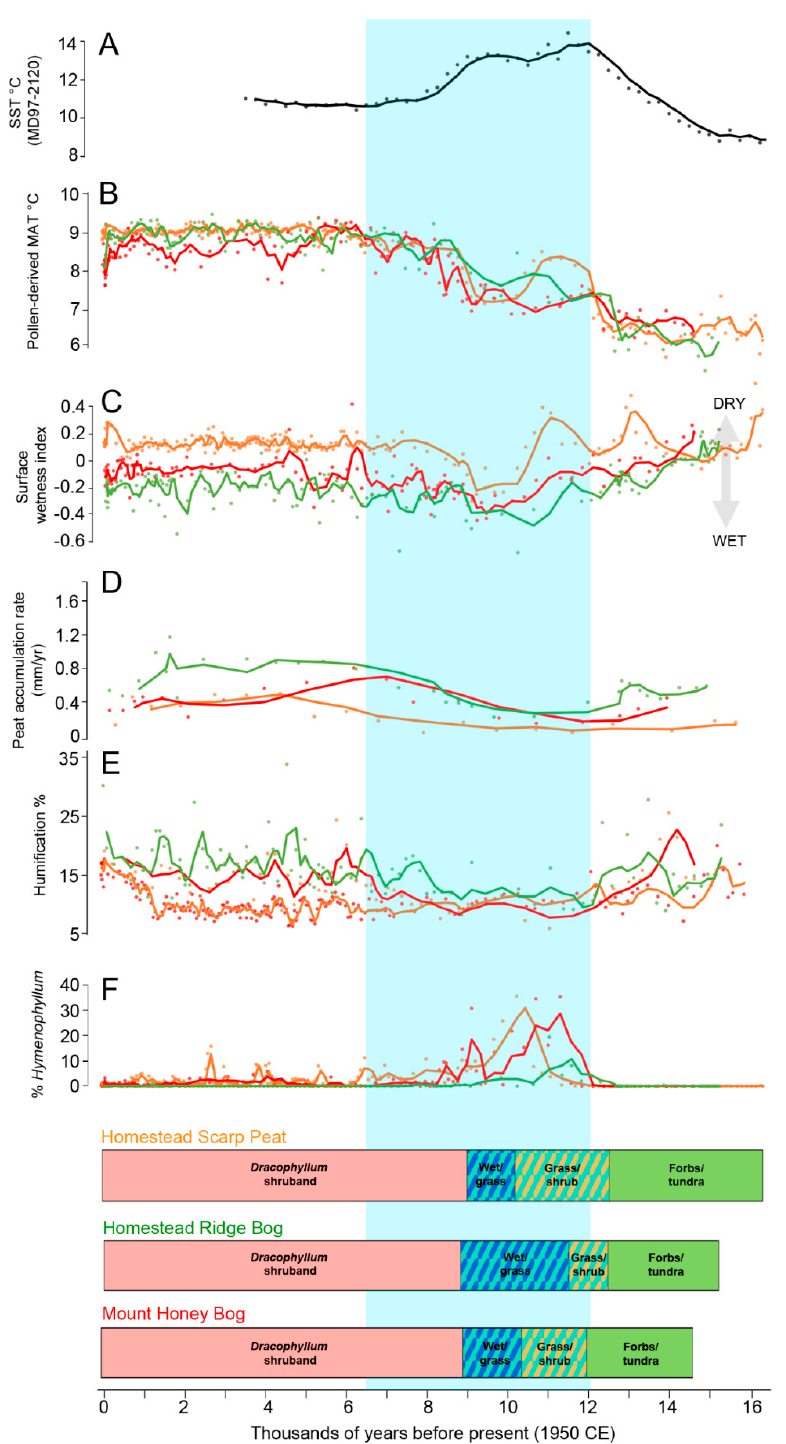
Figure 5. SST, deep sea core MD97-2120 off south-eastern South Island [38] ( a ). Panels ( b ) to ( f ) from analyses of peat sites HSP (yellow), HRB (green), and MHB (red). Equivalent mean January (summer) Campbell temperature [8] ( b ). Surface wetness proxy (NMS axis 2) ( c ). Vertical peat accumulation ( d ). Humification index (% transmission) ( e ). Hymenophyllum (filmy fern) spore percentages ( f ). Blue vertical shading represents the period during the Holocene (12,000 to 6500 BP) when the tree line was repressed.